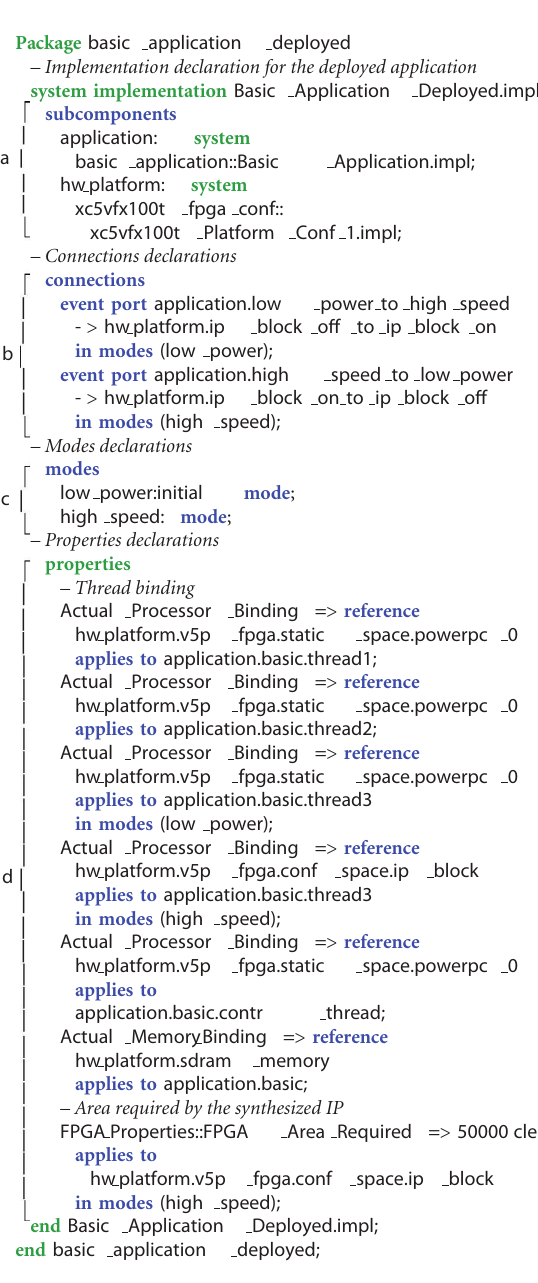
Figure 9: The software application deployed onto the configured hardware platform to constitute a